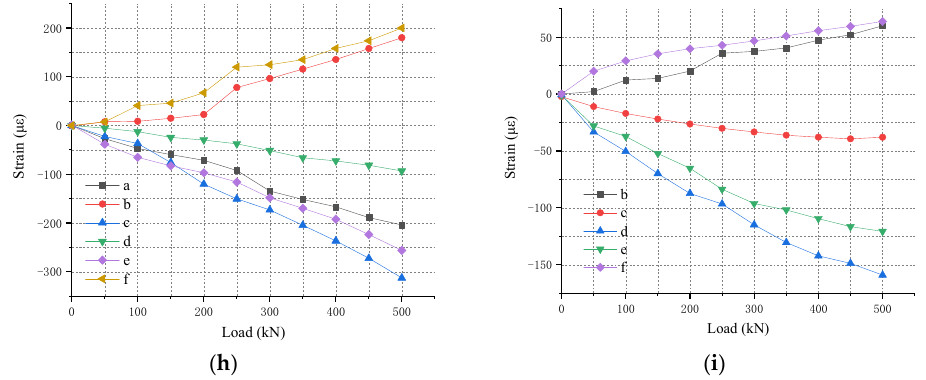
Figure 12. Strain–load curves of steel bars. ( a ) V0; ( b ) V1/4; ( c ) V1/3; ( d ) V1/2; ( e ) V2/3; ( f ) R1/4; ( g ) R1/3; ( h ) R1/2; ( i ) R2/3.